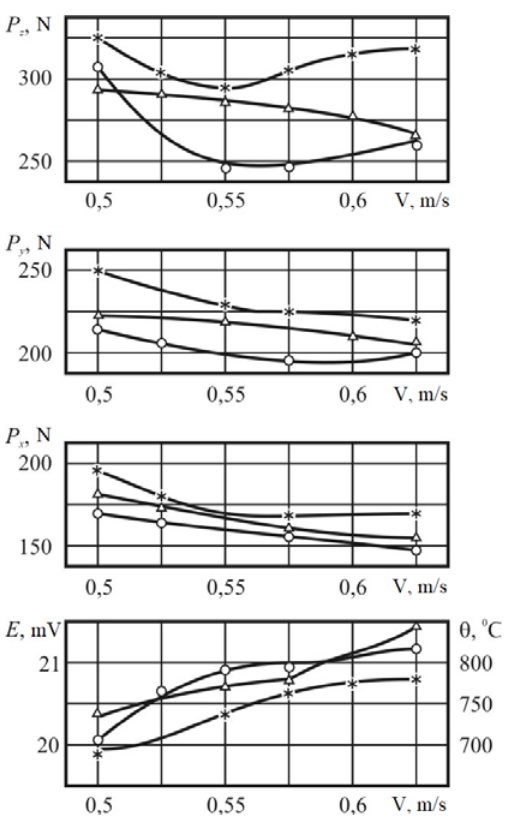
Fig. 1. Dependence of the components of the cutting force, thermo-EMF and temperature on the cutting speed when turning ХN73MBTU – H10 (- av> 0; - av <0; - av = 0; s = 0.1 mm / rev; t = 0.5